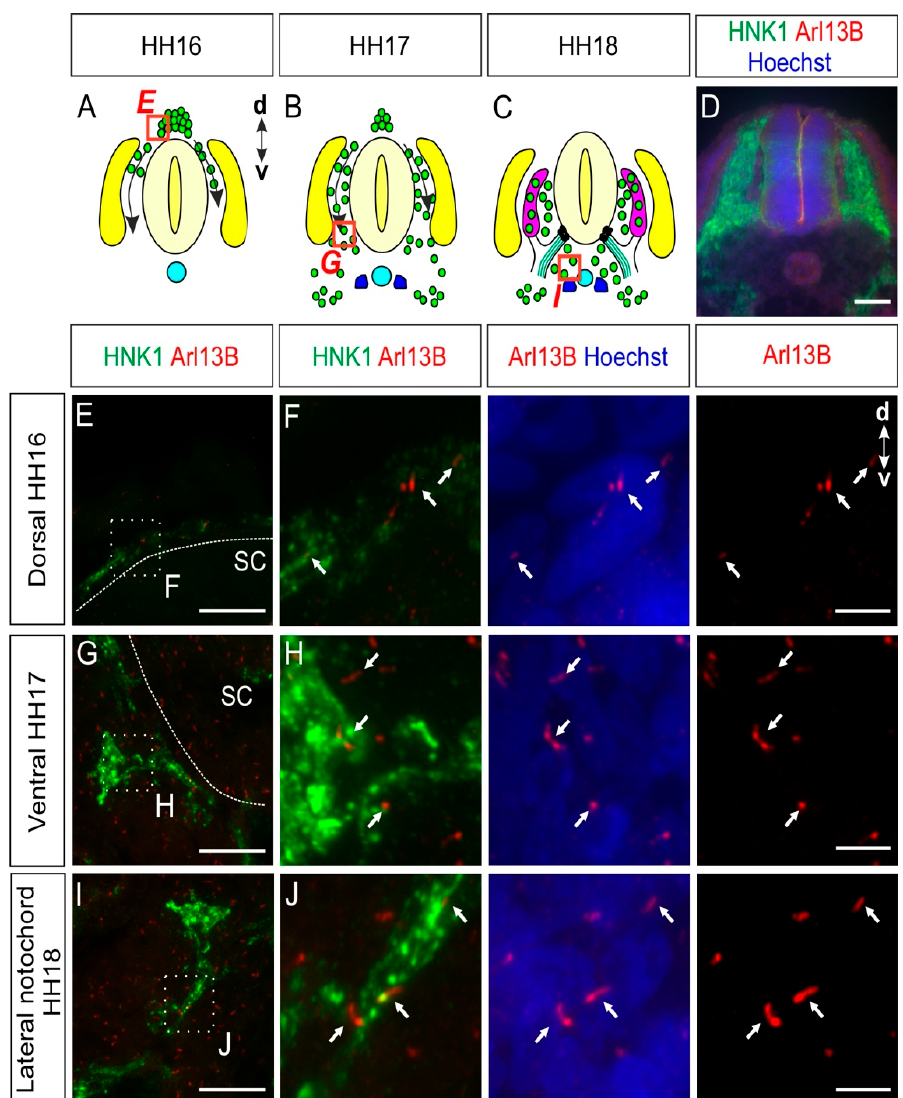
Figure 1. Trunk neural crest cells (NCCs) possess a primary cilium during early migration and settlement. ( A – C ) Trunk NCCs migrate ventrally between HH16 and HH18 on both sides of the neural tube. Green: NCCs, turquoise: notochord, purple: dorsal root ganglia (DRG), yellow: dermomyotome, blue: sympathetic ganglia chain, black dots: boundary cap cells (BCCs), green lines: ventral roots. d, dorsal; v, ventral. ( D ) A transverse section of the spinal cord of an HH18 embryo stained with HNK1 to stain NCCs (green) and with Arl13B antibodies to visualize primary cilia (red). Nuclei were counterstained with Hoechst (blue). ( E , F ) NCCs were visualized at HH16 before arriving at the dorsal root level. They were found to bear a primary cilium (white arrows). ( G – J ) NCCs located at the ventral root level ( G ) and the area lateral to the notochord ( I ) possessed a primary cilium (white arrows). Squares with dashed lines represent the region of interest shown in the right panels. Dashed lines represent the boundary of the spinal cord. d, dorsal; v, ventral; SC, spinal cord. Scale bars: 100 ( D ), 25 ( E , G , I ), and 5 μ m ( F , H , J ).